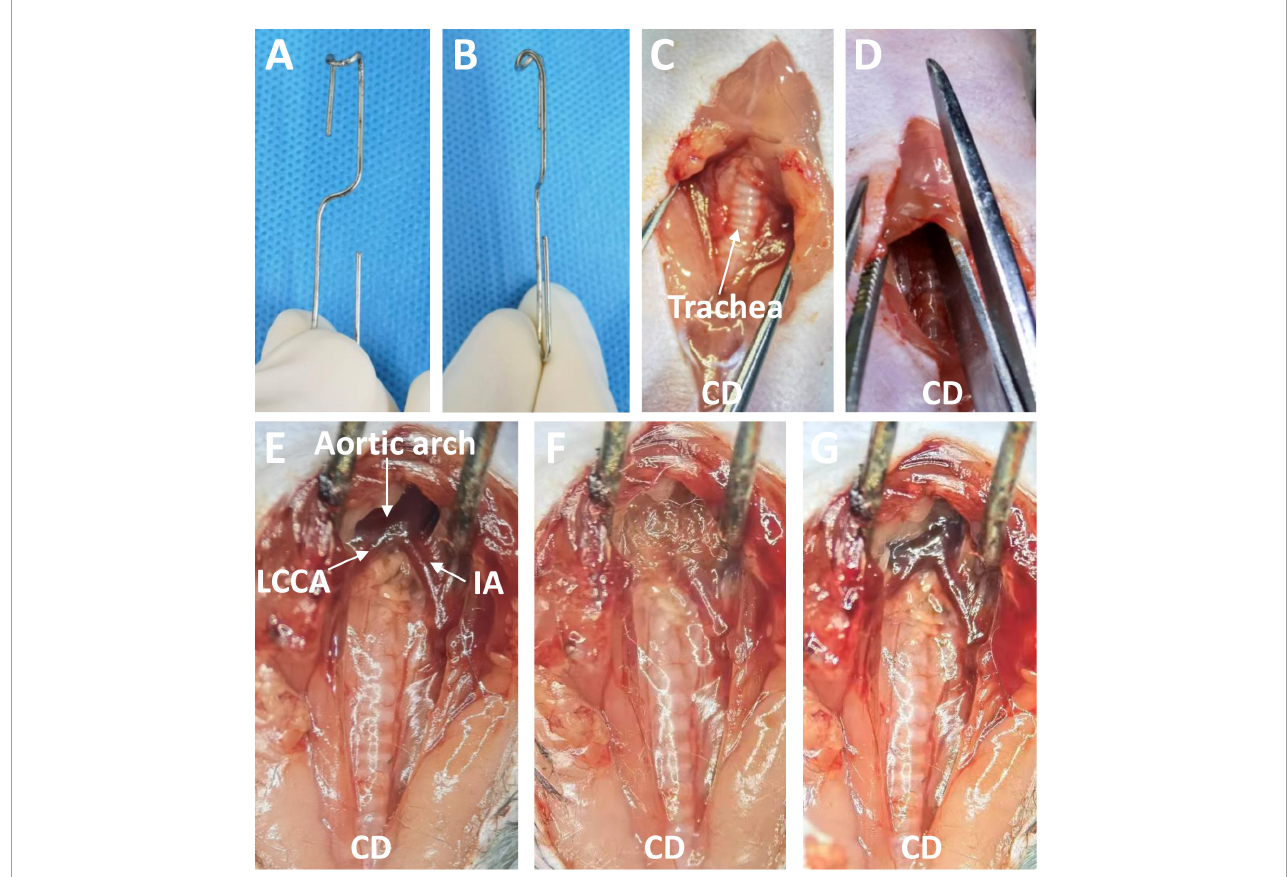
FIGURE1 The blunt hook and the surgical process used to induce a thoracic aortic aneurysm through a midline incision in the anterior neck. (A) Front view of the blunt hook. (B) Side view of the blunt hook. (C) The skin was opened, and the thyroid gland and muscles in front of the trachea were pulled toward both sides. (D) The sternum was cut to the second rib. (E) The sternum was pulled 30 to 45 degrees forward and upward, exposing the targeted aorta. (F) An elastase- or saline-soaked sponge was applied. (G) The sponge was removed (Elastase application group). CD, cephalad direction; IA, innominate artery; LCCA, left common cervical